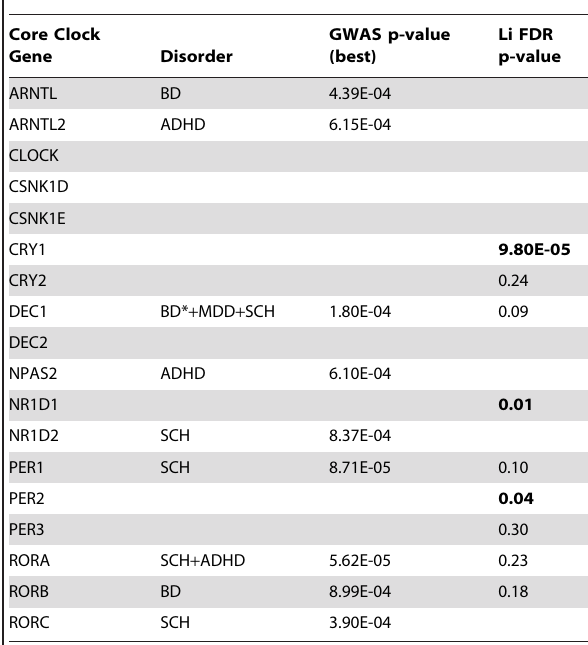
Table 1. Core clock